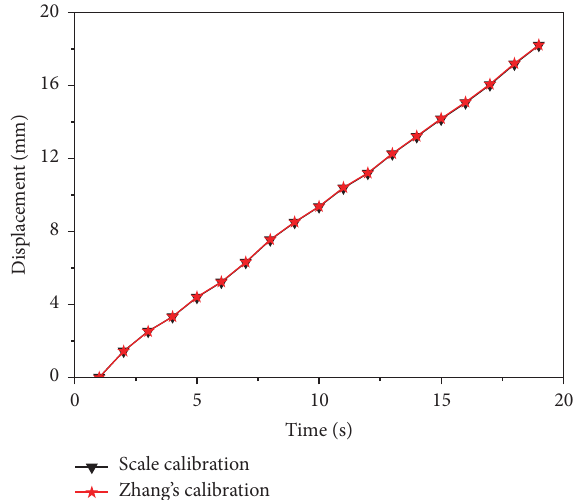
Figure 5: Displacement measurement results of two calibration methods.